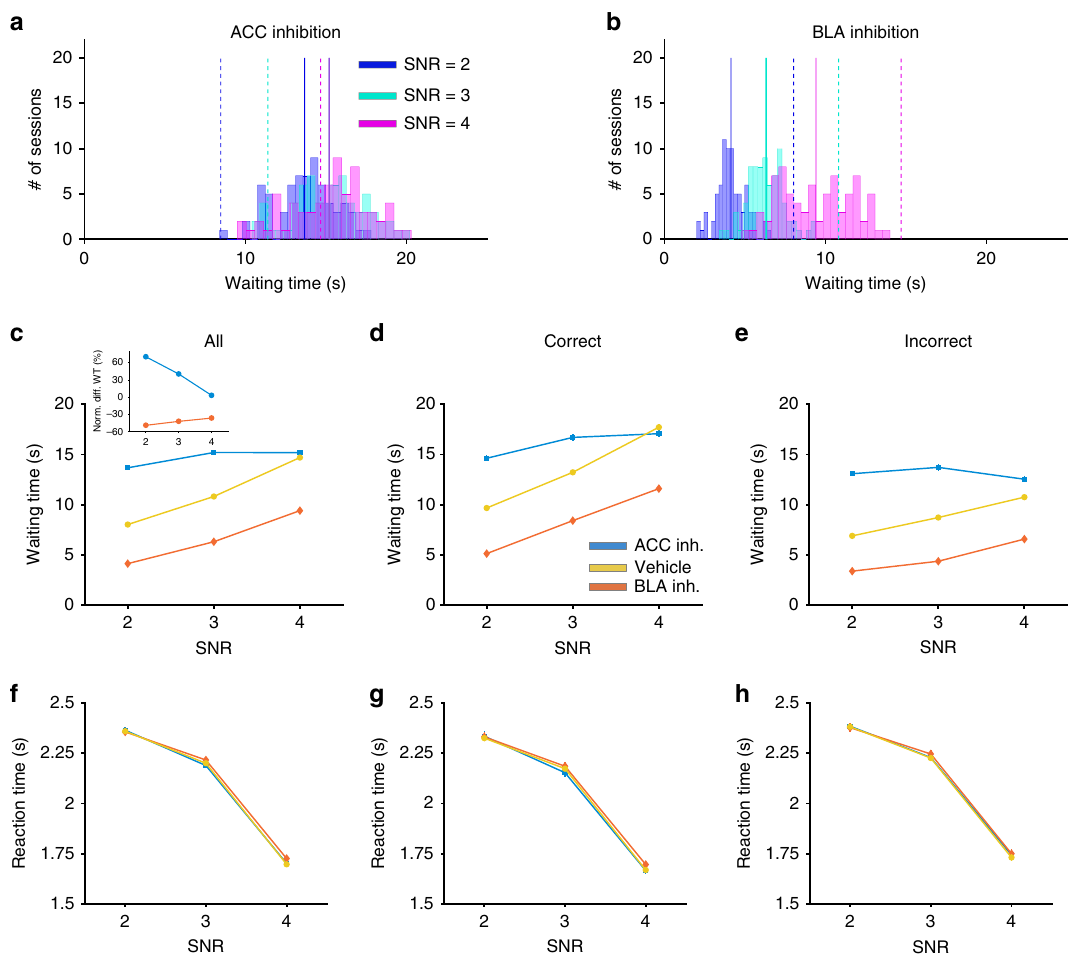
Fig. 4 ACC and BLA inhibition result in opposing changes in waiting time, but no change in reaction times. a Waiting time increases following ACC inhibition. Plotted are the distributions of the waiting time separately for each SNR, following ACC inhibition. Solid lines show the median of each distribution. Dashed lines show the median of the same condition but following vehicle administration as is shown in Fig. 2a. b Waiting time decreases following BLA inhibition. Same as in panel A but for sessions following inhibition of BLA. c Inhibition of ACC renders waiting times insensitive to the strength of sensory signal, whereas BLA inhibition shift waiting times. Plotted is the waiting time for all trials as a function of SNR following vehicle administration (yellow), inhibition of BLA (orange), and inhibition of ACC (blue). d , e Same as in panel ( c ) but only on trials in which a correct ( d ) or incorrect ( e ) response was made. Error bars show the S.E.M. over sessions (typically smaller than the symbols). f Reaction time is unaffected by inhibition of either ACC or BLA. Plotted is the reaction time for all trials as a function of SNR following vehicle administration (yellow), inhibition of BLA (orange), and inhibition of ACC (blue). g , h Same as in panel ( f ) but only on trials in which a correct ( g ) or incorrect ( h ) response was made. Source data are provided as